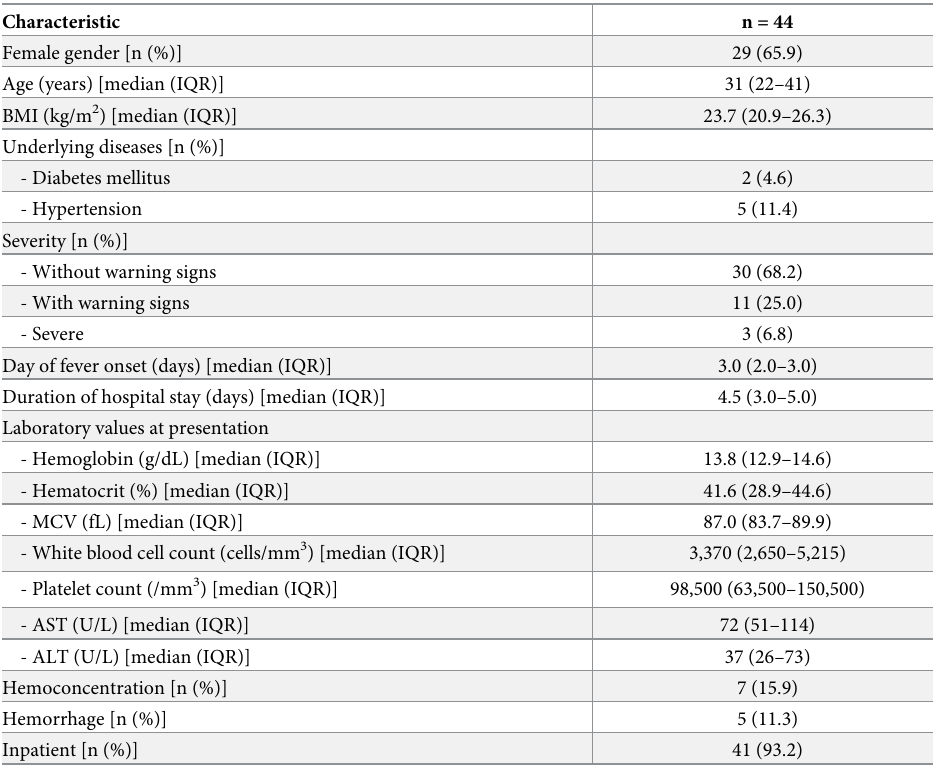
Table 1. Characteristics of 44 dengue